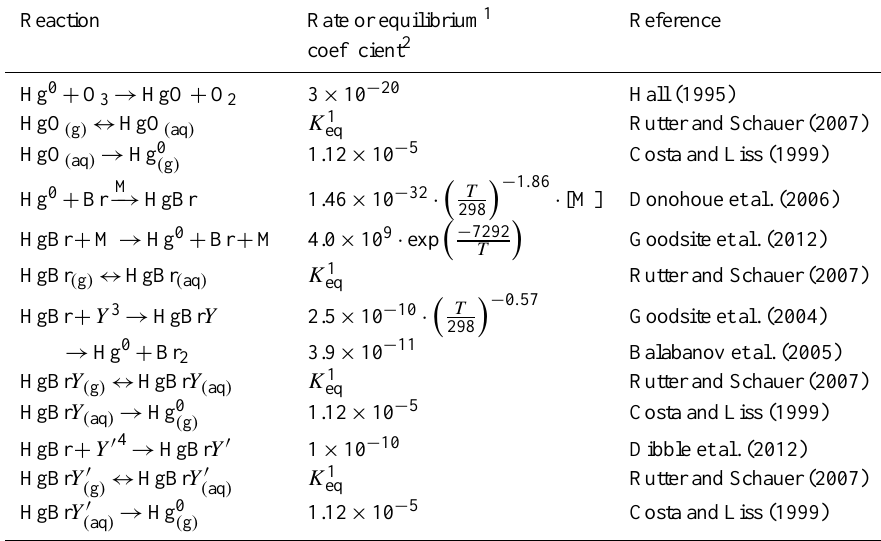
Table 2. Summary of mercury reactions and rate coefficients used in the box model.